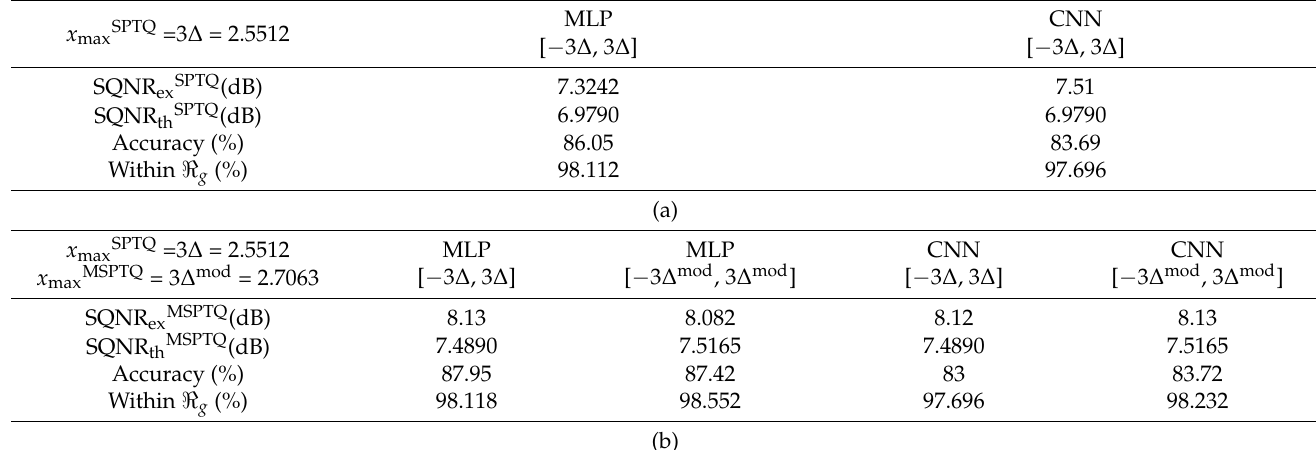
Table 7. SQNR and QNN model’s accuracy (MLP and CNN trained on Fashion-MNIST dataset) with the application of (a) SPTQ (b) MSPTQ, designed for bit rate of R = 2